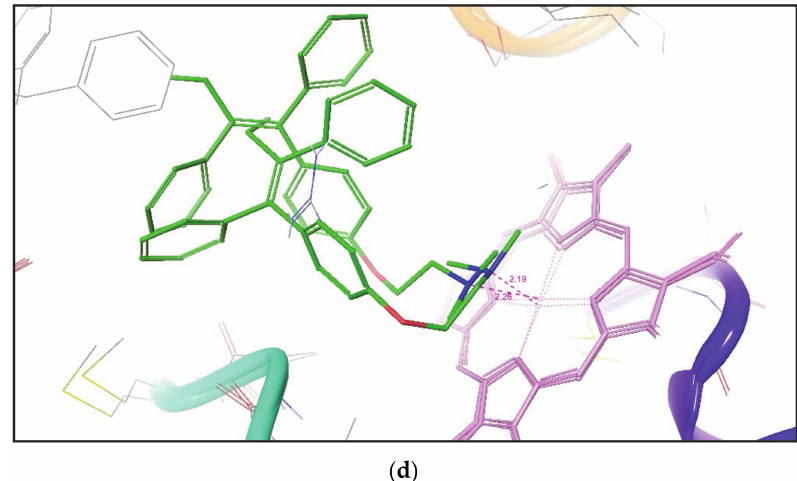
Figure 4. Superimposition of the IFD docking pose of ligands in CYP3A4 enzyme ( a ) Alprazolam (1W0E-1W0G)-Site 1, ( b ) Alprazolam (1W0E-1W0G)-Site 2, ( c ) Nevirapine (1W0F-3NXU), and ( d ) Tamoxifen (1W0G-1TQN). The pink dotted line indicates the distance between SOM and the heme Fe